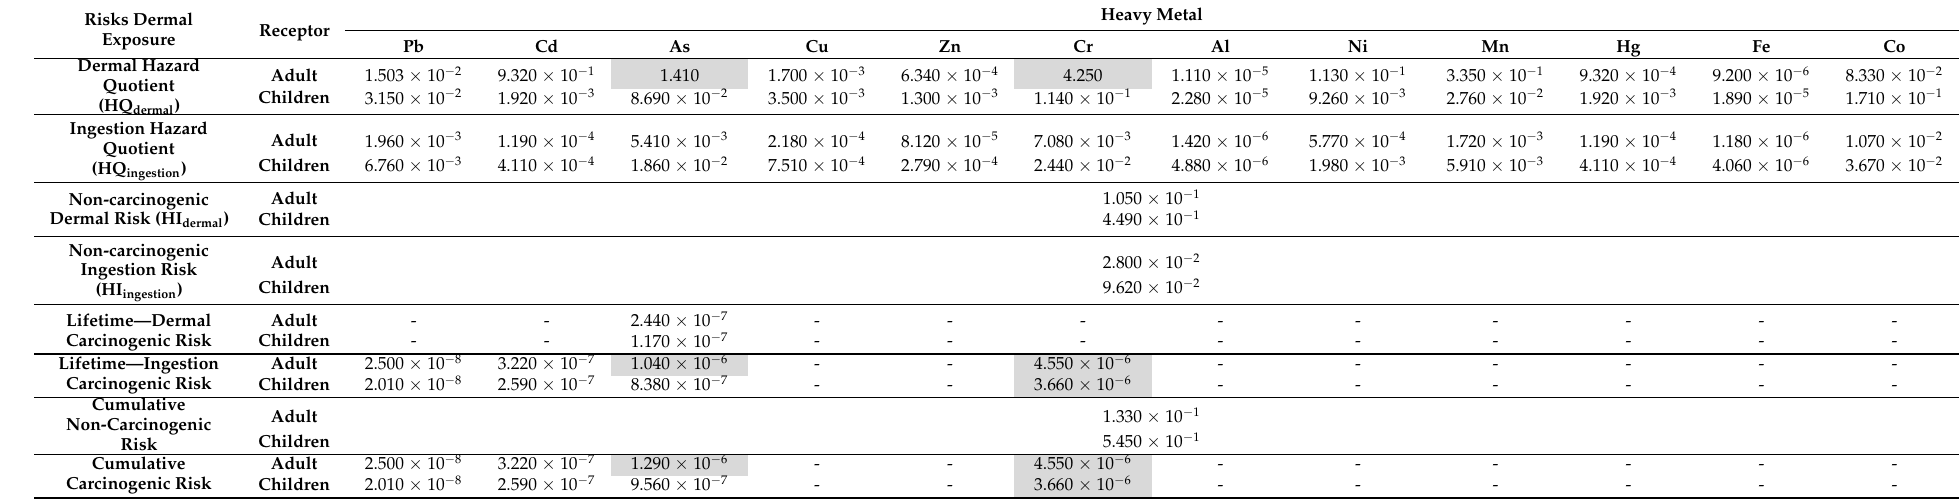
Table 3. Human non-carcinogenic and carcinogenic risk of heavy metals from sediments considering accidental ingestion or dermal contact. Risks Dermal